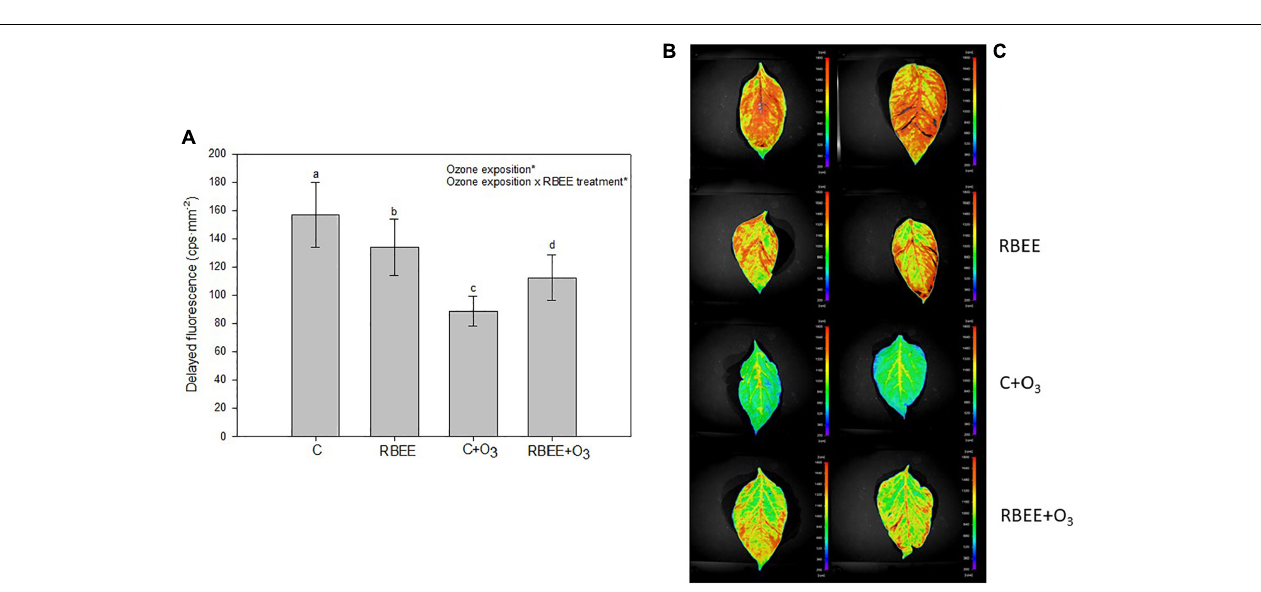
FIGURE 1 | Physiological parameters. (A) Net photosynthetic rate (A N ) and (B) total chlorophyll content in pepper plants in response to two conditions of ozone (O 3 ) (0 and 100 ppm) under a treatment without and with rice bran enzymatic extract (RBEE). Values represent mean ± SD, n = 5. Different letters indicate means that are significantly different from each other (two-way ANOVA, O 3 exposition × RBEE treatment; HSD test, P < 0.05). O 3 exposition and RBEE treatment in the corner of the panel indicate main or interaction significant effects (* P < 0.05; ** P < 0.01; *** P < 0.0001).